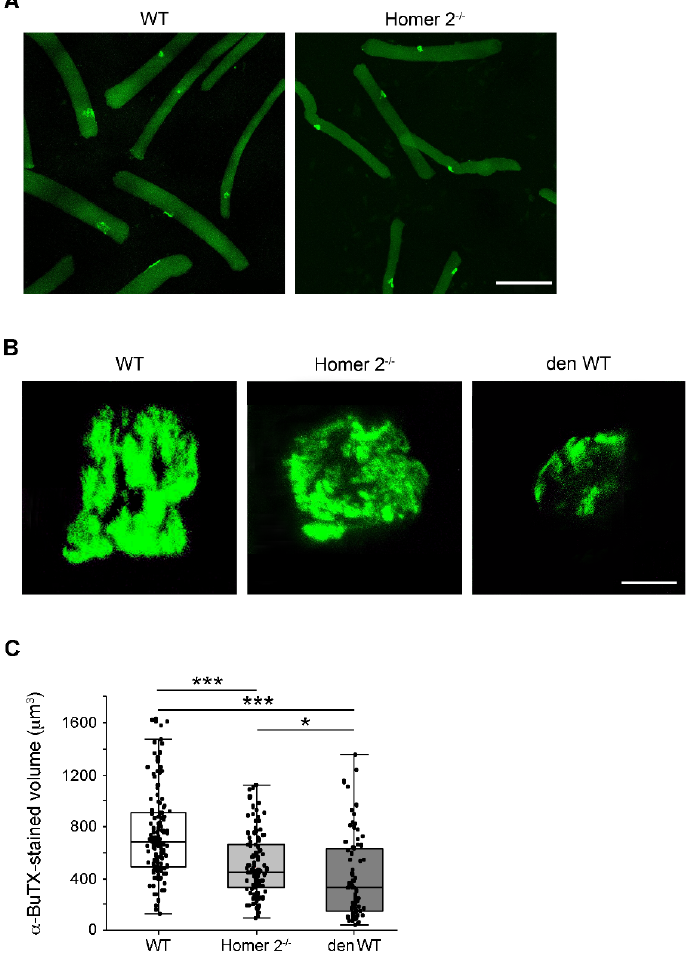
Figure 5. The endplate morphology in WT and Homer 2 ‐ / ‐ FDB muscle fibres. ( A ) nAChR